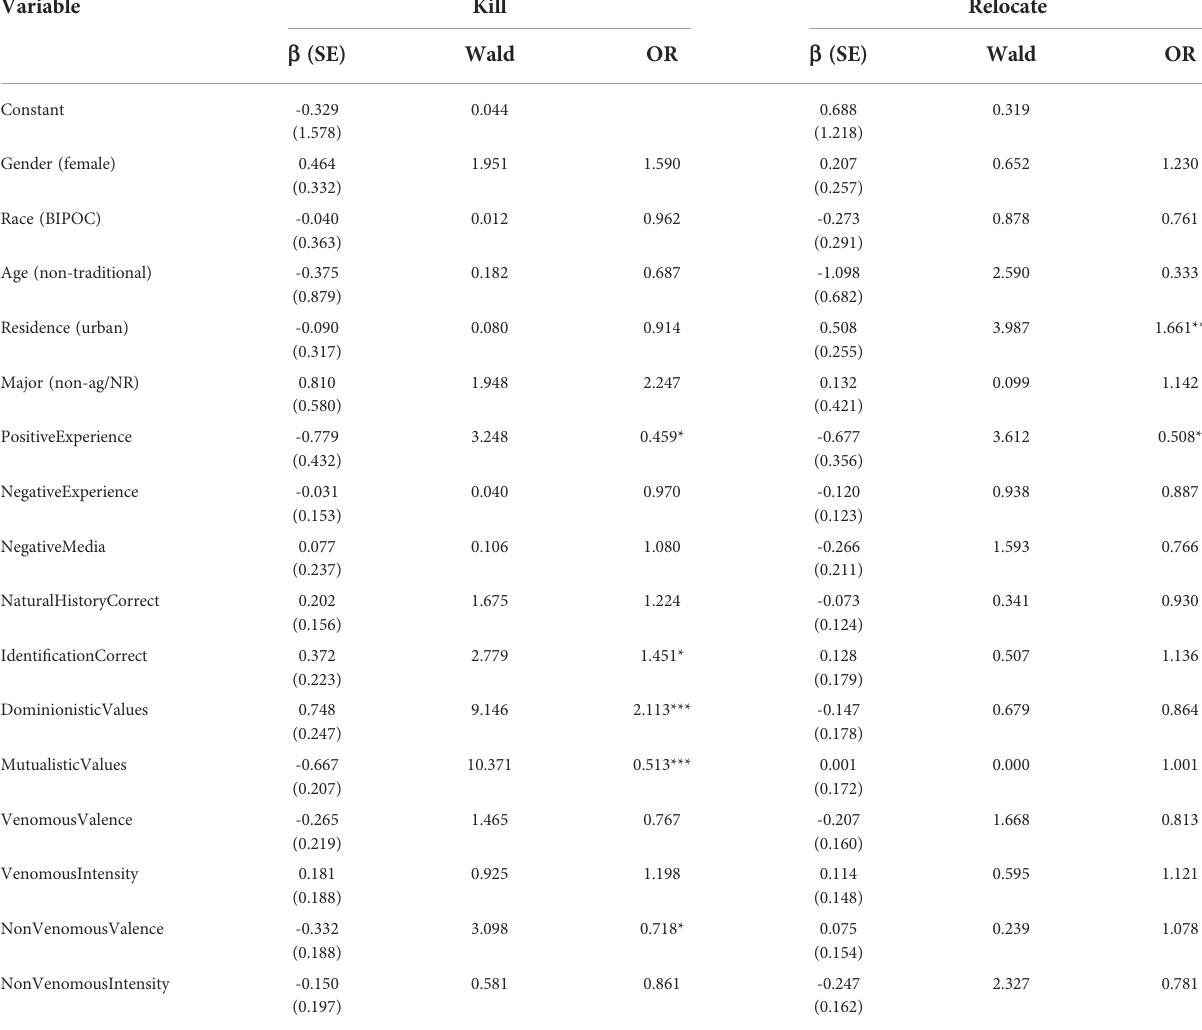
TABLE 4 Parameter estimation from the multinomial logistic regression model predicting tolerance of snakes that were not know to be venomous or non-venomous (measured as reaction to seeing an unknown type of snake “ right outside of your residence ” ) among undergraduate students in North Carolina (n =